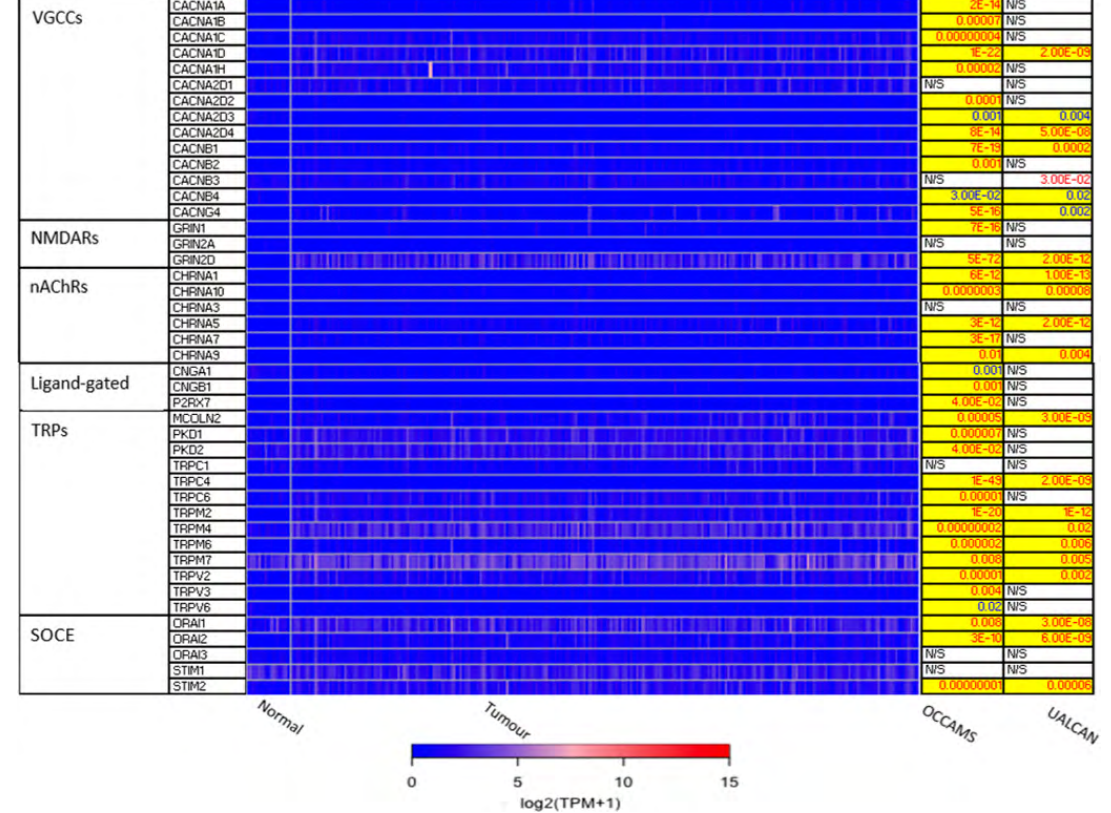
Figure 4. Expression of Ca 2+ channels in OAC. MCOLN1 was not available from the OCCAMS data. MCOLN1 was upregulated, compared to normal tissue, in the UALCAN data ( P = 9.95E-4). Please see Figure 2 for details. NMDARs: N -methyl- D -aspartate receptors; nAChRs: nicotinic acetylcholine receptors; CNGA: cyclic-nucleotide-gated channel subunit α; CNGB: cyclic-nucleotide-gated channel subunit β; P2RX7: purinergic receptor P2X, ligand-gated ion channel 7; PKD: polycystin; CHRNA: nAChR